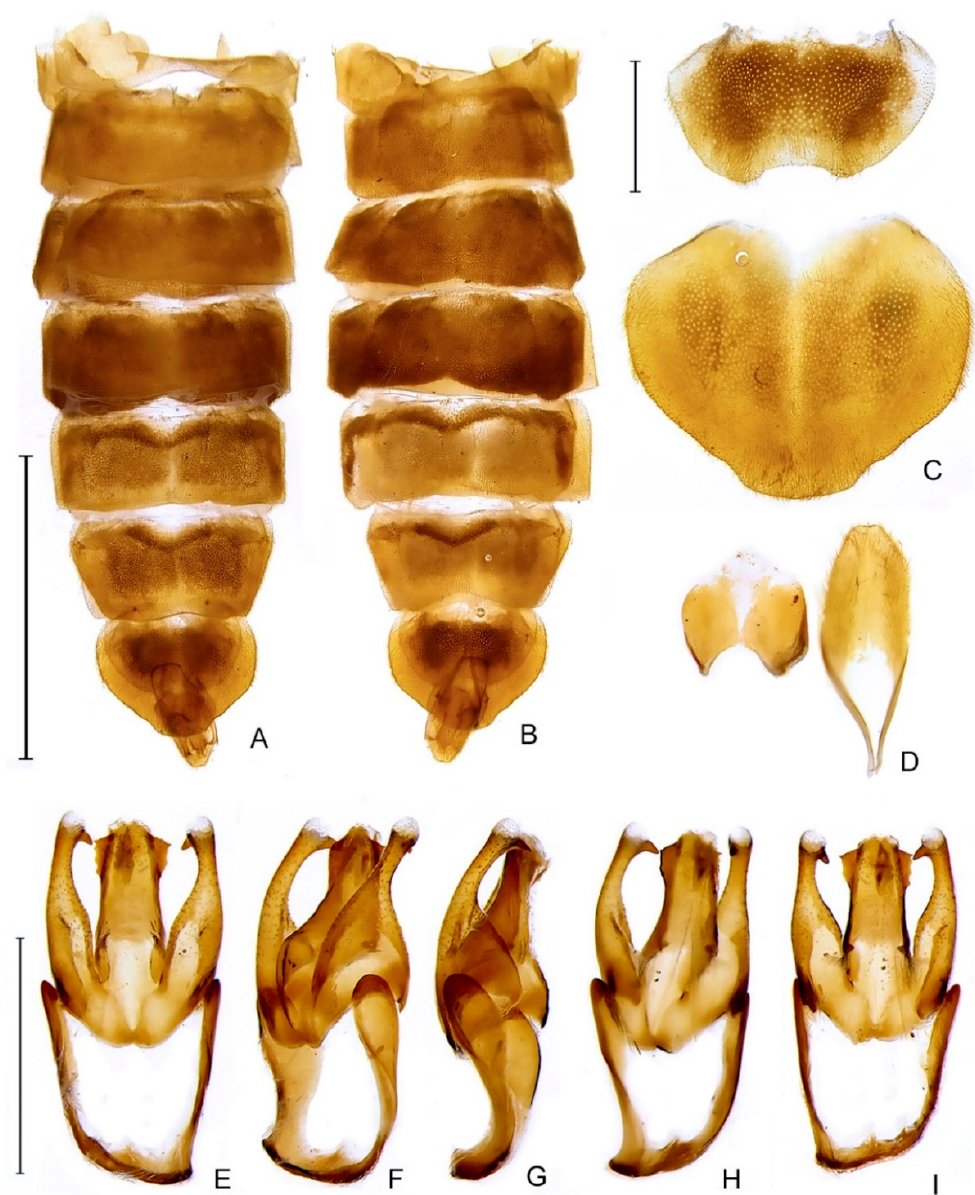
Figure 9. Zoiudo araucariorum sp. nov., abdomen: ( A ) dorsal, ( B ) ventral. ( C ) Pygidium, dorsal and sternum VIII, ventral. ( D ) Aedeagal sheath (syntergite, dorsal; sternum IX, ventral). ( E – I ) Aedeagus: ( E ) dorsal, ( F ) dorso-lateral, ( G ) lateral, ( H ) lateroventral, ( I ) ventral. Scale bars: ( A , B ): 5 mm; ( C , D ): 1 mm; ( E – I ): 1 mm.